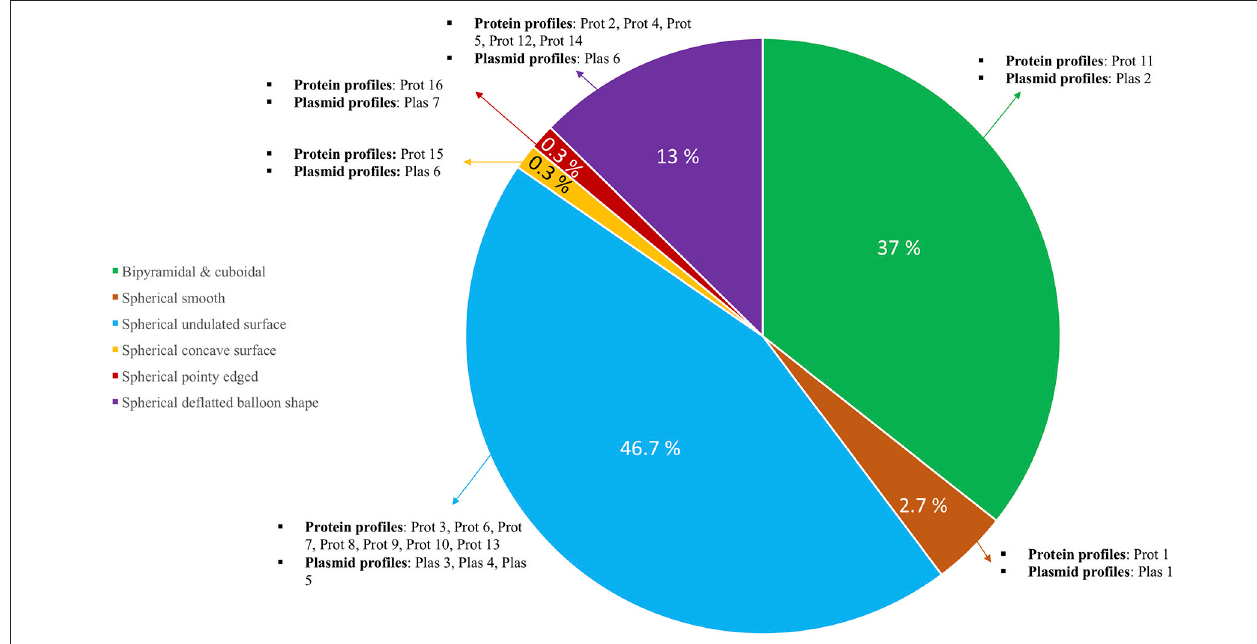
FIGURE 5 | Pie chart showing the diversity among 700 Qatari Bt isolates. Main distribution in the pie is based on crystal forms and each section has been further classified based on the types of protein and plasmid profiles observed among